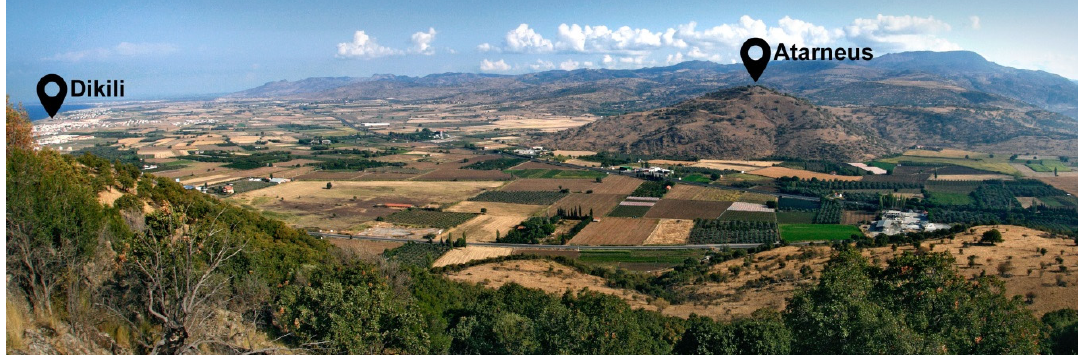
Figure 13. Atarneus. Left: Coastline west of Atarneus and northern outskirts of modern Dikili. Right: Narrow passage into the western lower Bak ı rçay Valley between Kozak and Kara Da ğ ı Mountains.